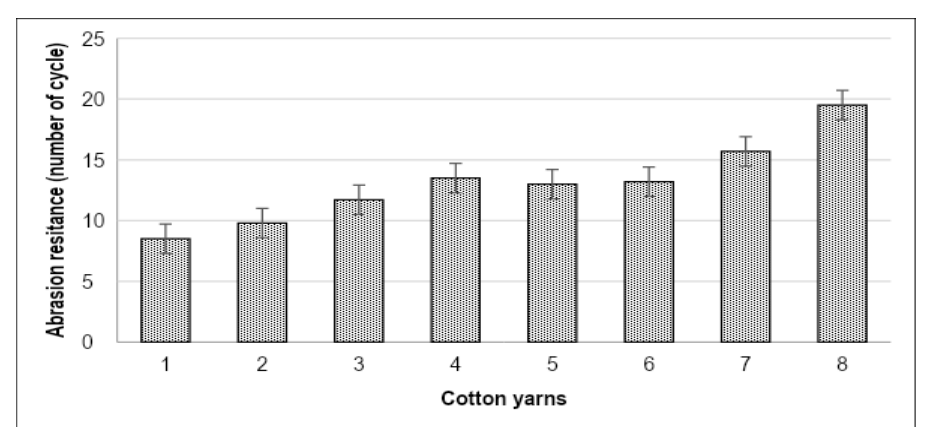
Fig. 3: Twist level and the abrasion resistance of yarns Table 3: Descriptive statistical analysis of yarn abrasion